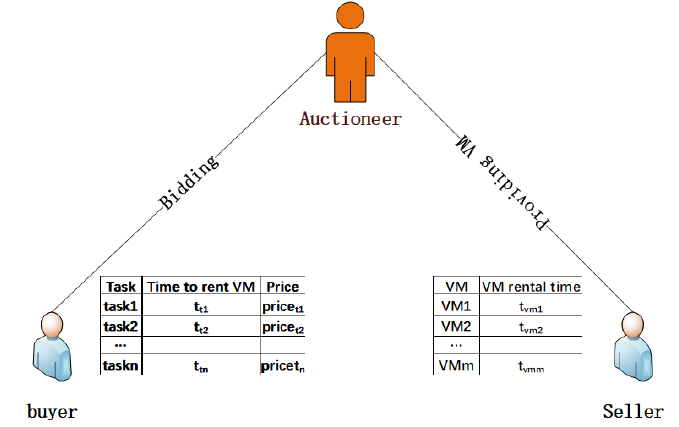
Figure 2. Auction model for task scheduling. There are two roles in the auction model: the buyer and seller. The seller provides goods, and the buyer participates in the auction of products that meet their own needs, and the higher price